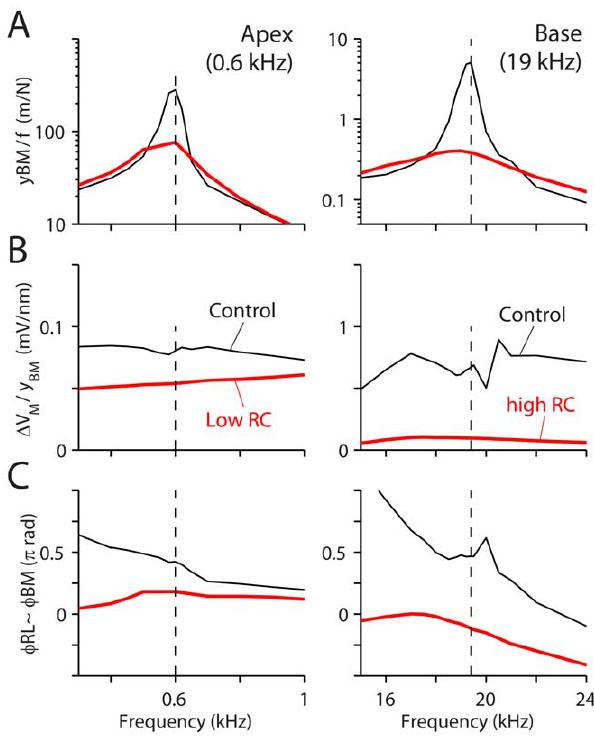
Figure 5. Effect of inappropriate electrical properties of the outer hair cell membrane. The basolateral membrane electrical properties (conductance and capacitance) of the OHC at the apex and the base were exchanged while all other conditions remained the same. The cochlear partitions from the apex and the base (left and right column respectively) were stimulated with pure tones. ( A ) Basilar membrane displacement normalized by applied force. ( B ) Receptor potential of an OHC in the middle of the simulated section normalized by BM displacement. ( C ) Phase difference between the RL and the BM displacement. Thick curves are from tested (with exchanged membrane properties) and the thin curves are from control cases.